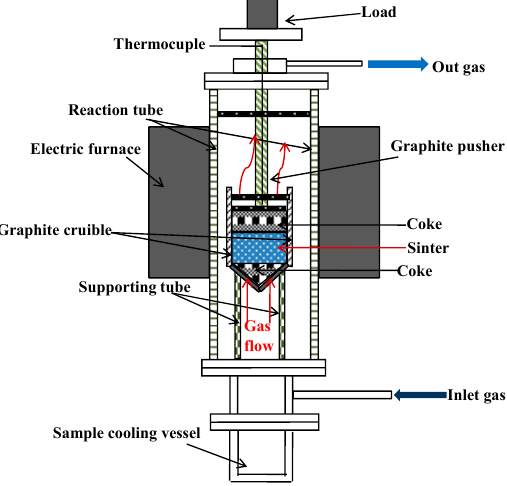
Figure 2. Experimental device for testing the melting properties of the sinter.